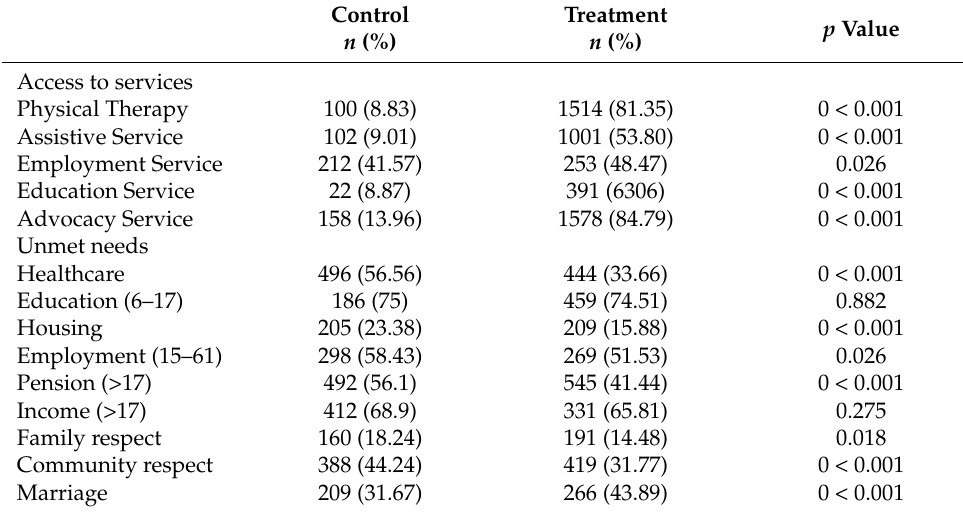
Table 2. Bivariate